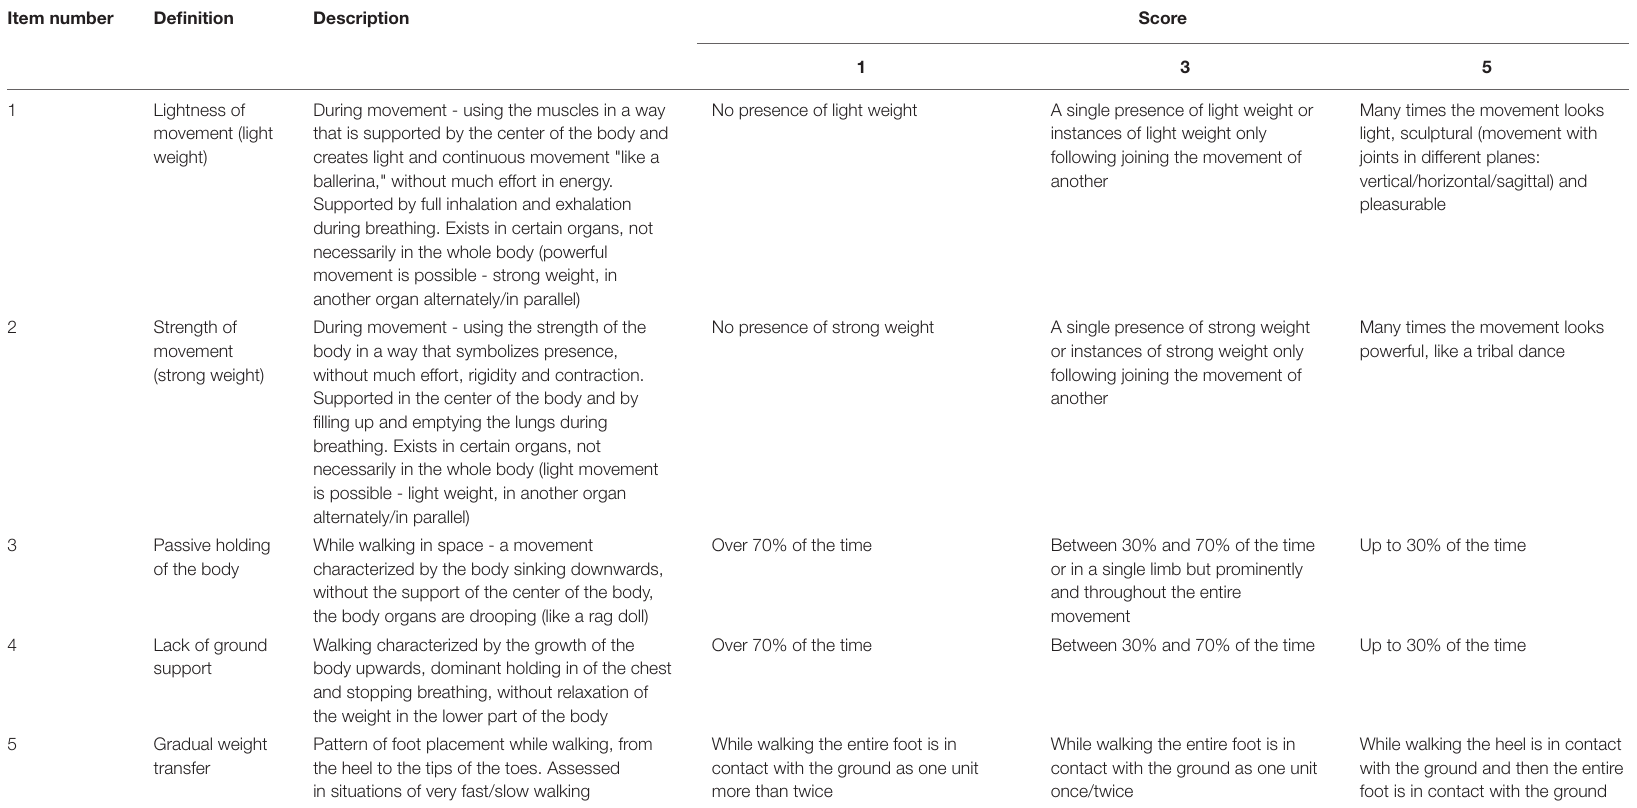
TABLE 3 | Grounding Assessment Tool